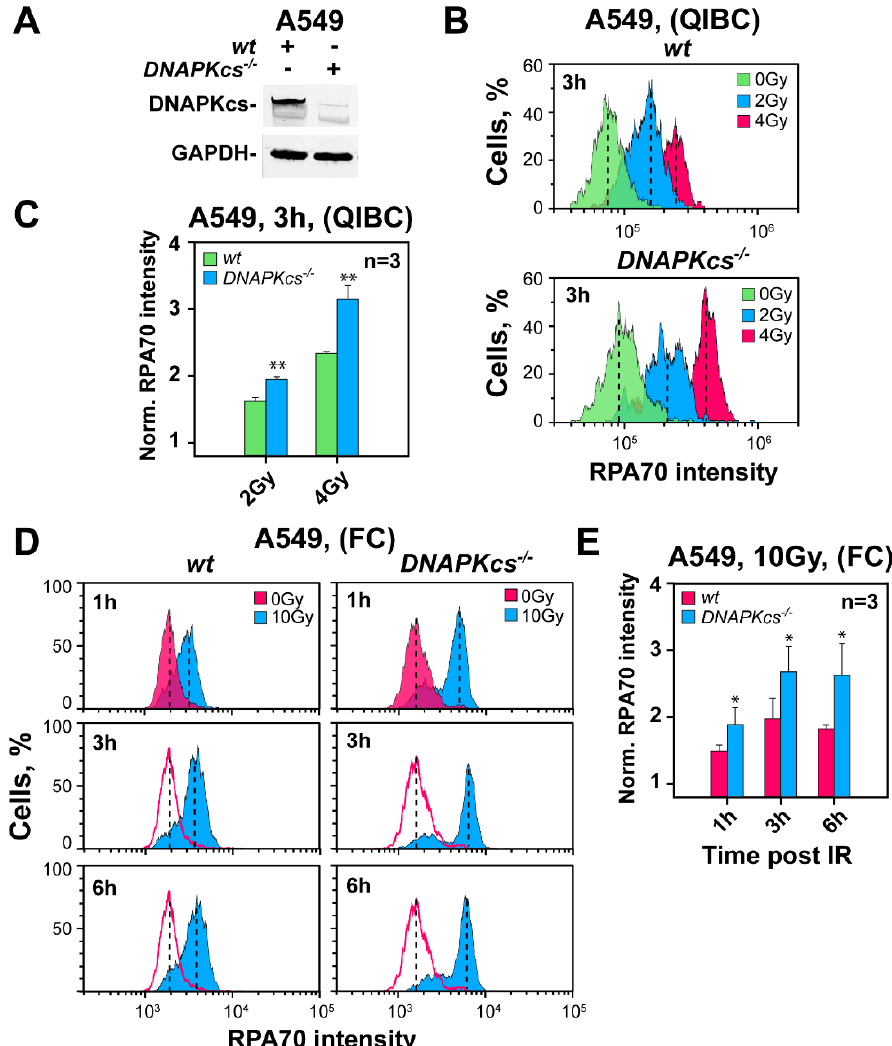
Figure 1. Detection in G 2 -phase of DNA end-resection in parental ( wt ) and DNA-PKcs -/- A549 cells. ( A ) Western blot showing strongly reduced DNA-PKcs levels in the selected clone of DNA-PKcs -/- A549 cells. ( B ) QIBC analysis of RPA70 signal at DSBs in wt and DNA-PKcs -/- A549 cells, 3 h after exposure to 2 Gy or 4 Gy. Resection is measured by calculating the arithmetic mean intensity of